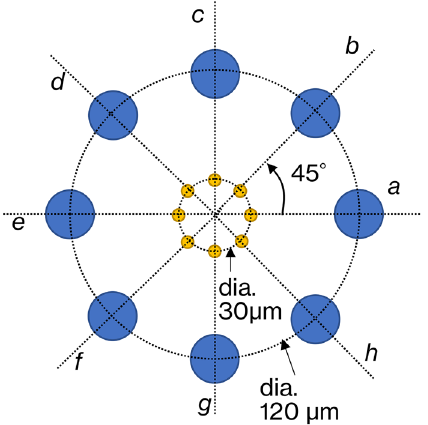
Figure 10. Numerical phantom for density resolution measurement in which eight circles of 5 µm diameter in concentric circles of 30 µm in diameter (drawn as yellow circles) and eight circles of 20 µm diameter in concentric circles of 120 µm in diameter (drawn as blue circles) are arranged at 45° intervals. Symbols a–h represent directions from the center of the phantom.